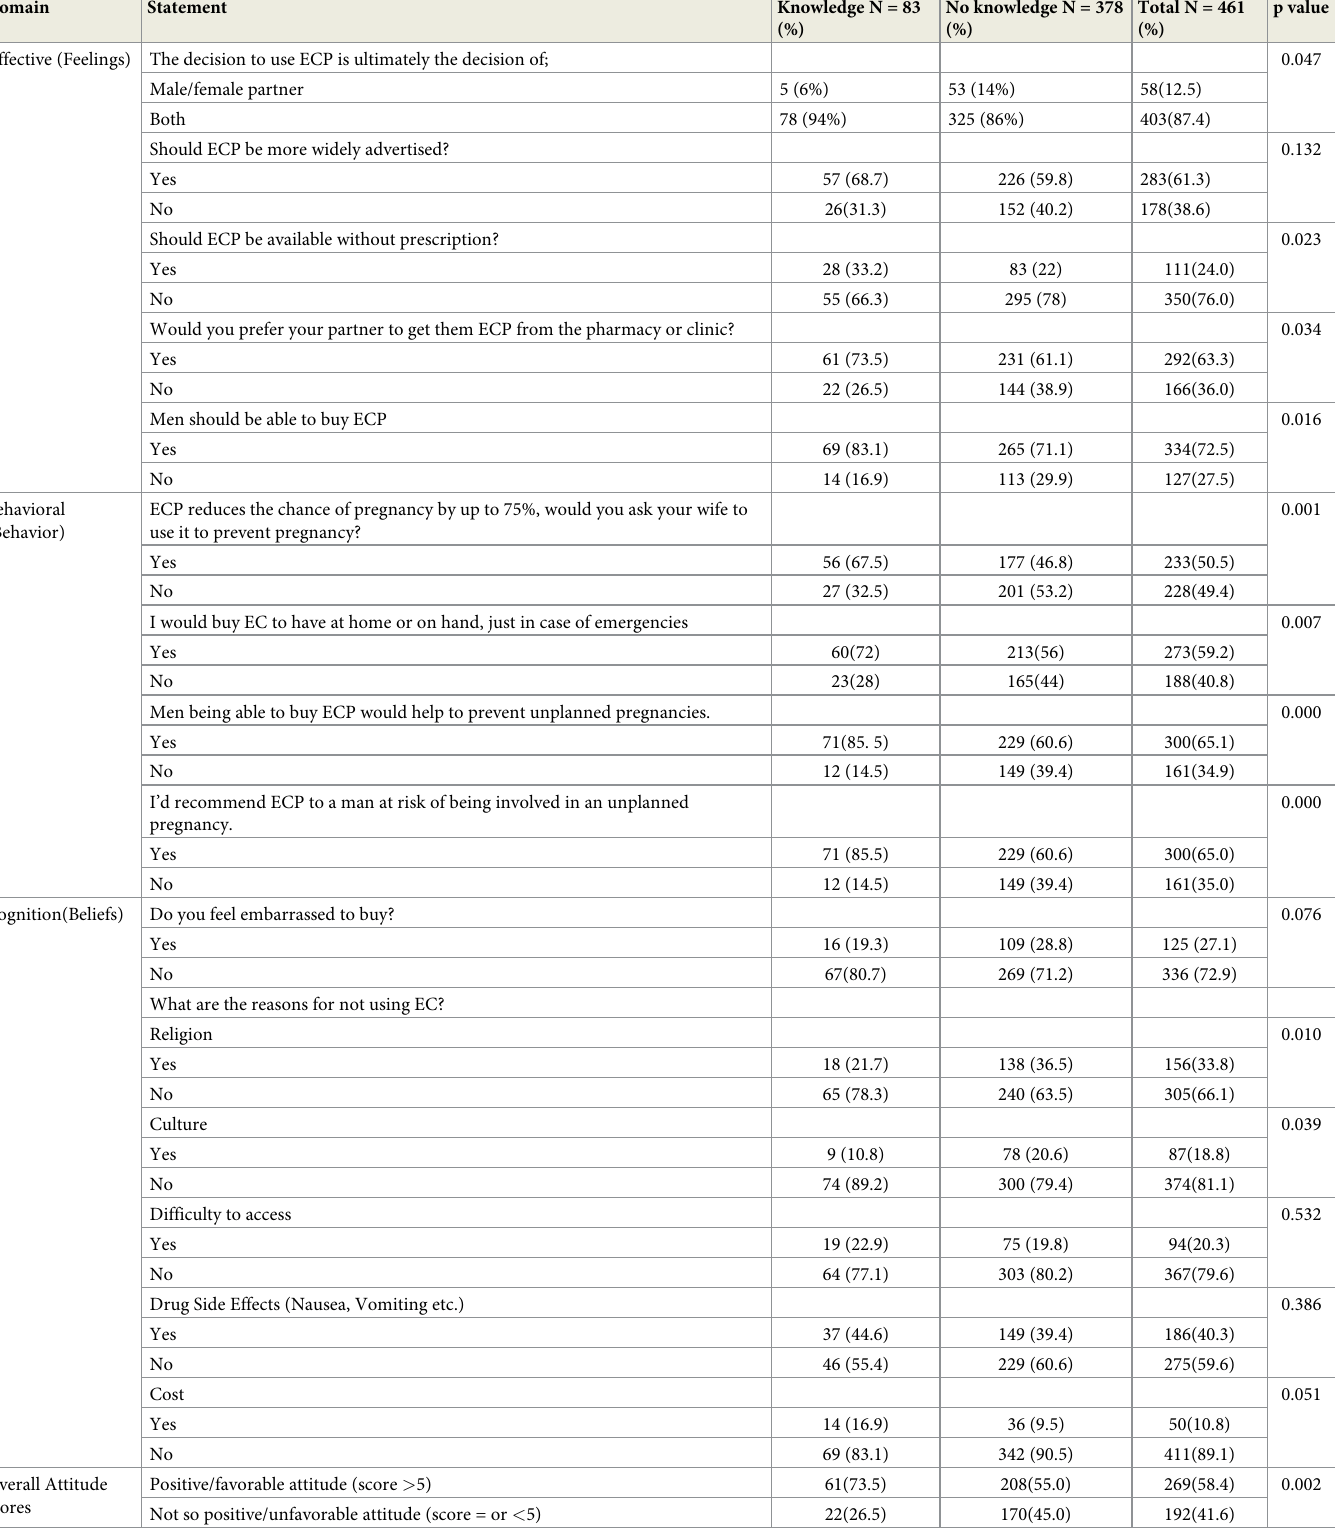
Table 4. Participants attitudes and beliefs regarding emergency contraception (n =